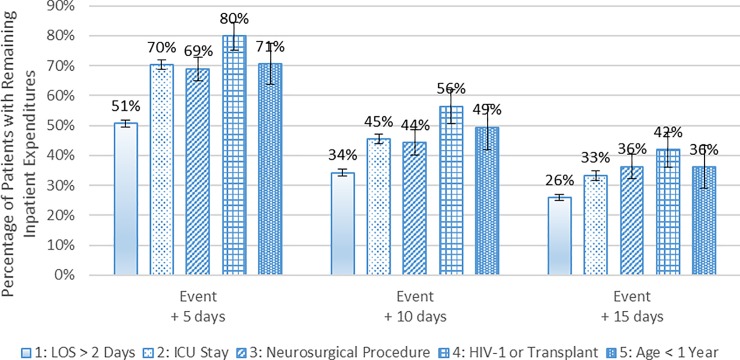
Percentage of patients with encephalitis who had inpatient expenditures after the subgroup-defining event, 2010 to 2014.Notes: The first 90 days and the last 90 days are excluded from the 2010 to 2014 period. For patients in Subgroup 4 (HIV-1 or Transplant) and Subgroup 5 (Age < 1 year), the subgroup-defining event day is the same as the initial hospital admission day because these patients could be classified into these subgroups upon admission. The values reported in the figure are the estimated percentages, and the error bars indicate the 95% confidence intervals of those estimates. Source: Authors’ analysis of 2010 to 2014 Truven Health MarketScan Commercial Claims and Encounters Database.